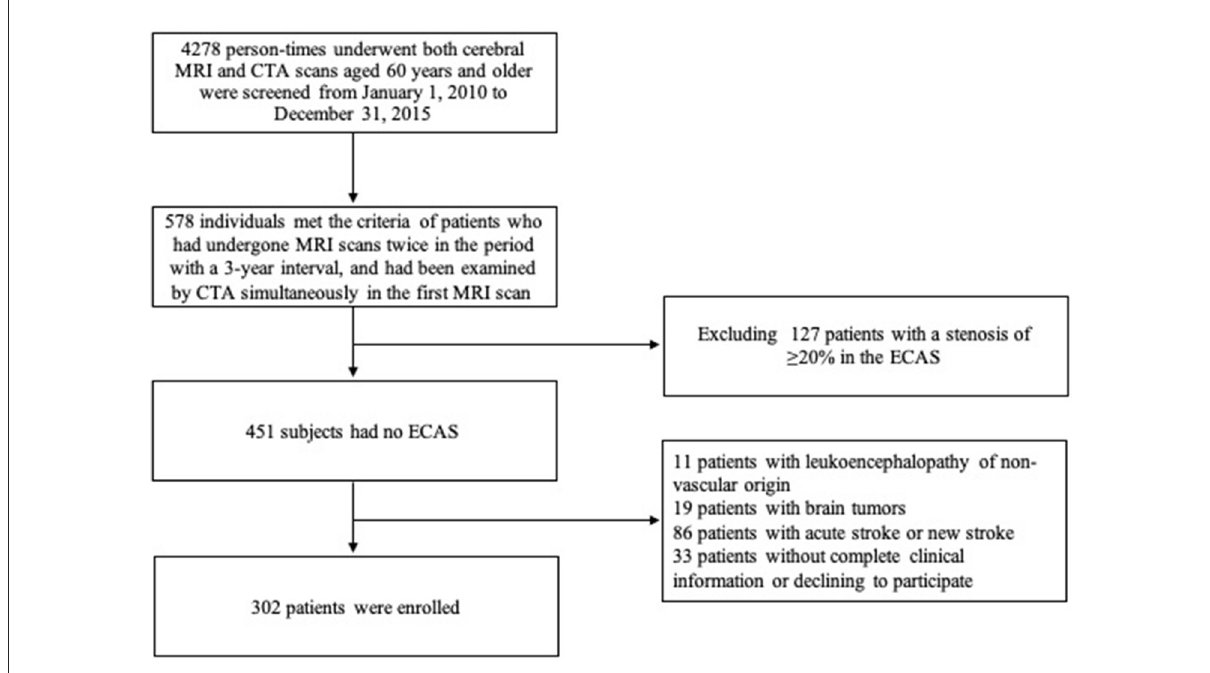
FIGURE1 Flow chart of patient screening for the present